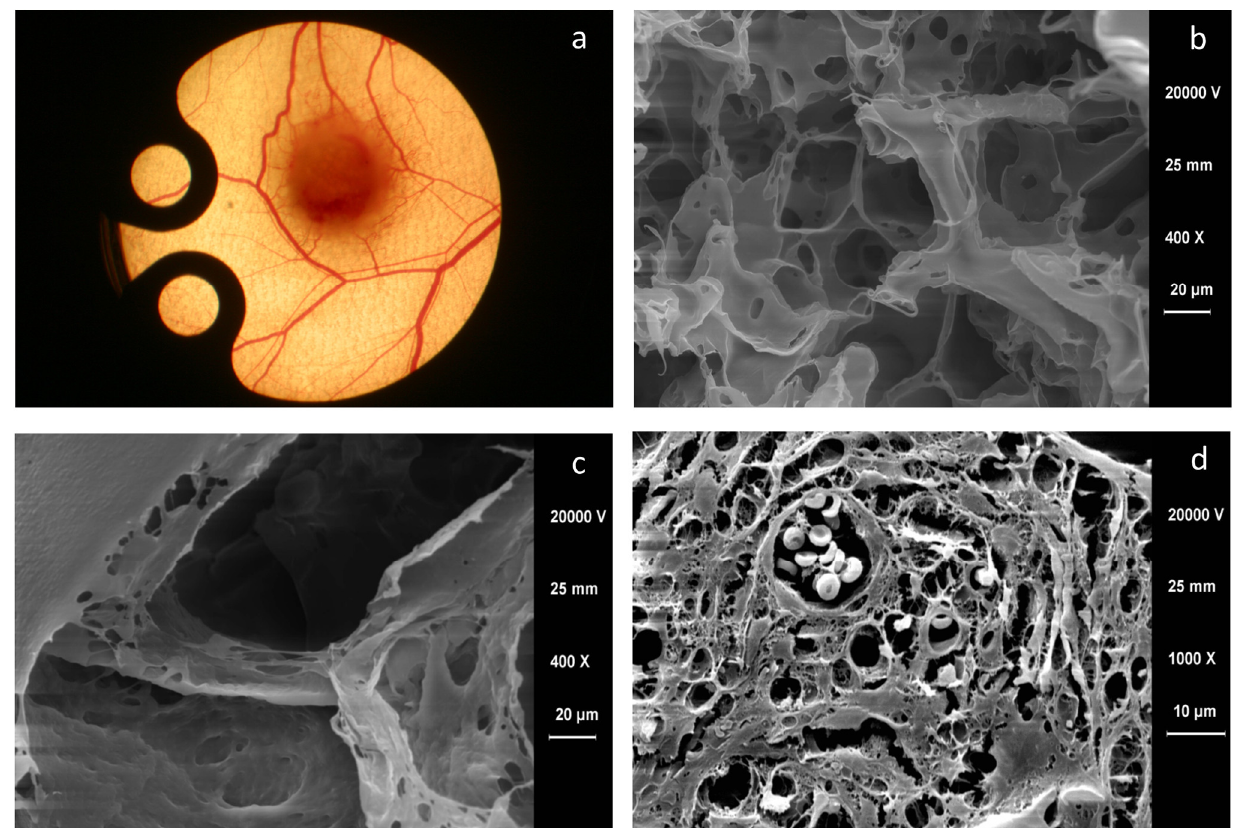
Figure 2. ( a ): Macroscopic image of a mouse dorsal skin fold chamber with implanted biomaterial. Of note, around the implanted material, a fine network of newly formed blood vessels can be seen. ( b , c ): Scanning electron micrographs of a highly porous, biodegradable 3-D matrix of lactocapromer terpolymer based on polylactide and polycaprolactone ( b ) and a biodegradable synthetic polyethylene glycol terephthalate/polybutylene terephthalate (PEGT/PBT)-block copolymer matrix with different porosity, 400× magnification. ( d ): Scanning electron micrographs of lactocapromer terpolymer with filled pores with multiple blood vessels, 1000× magnification.